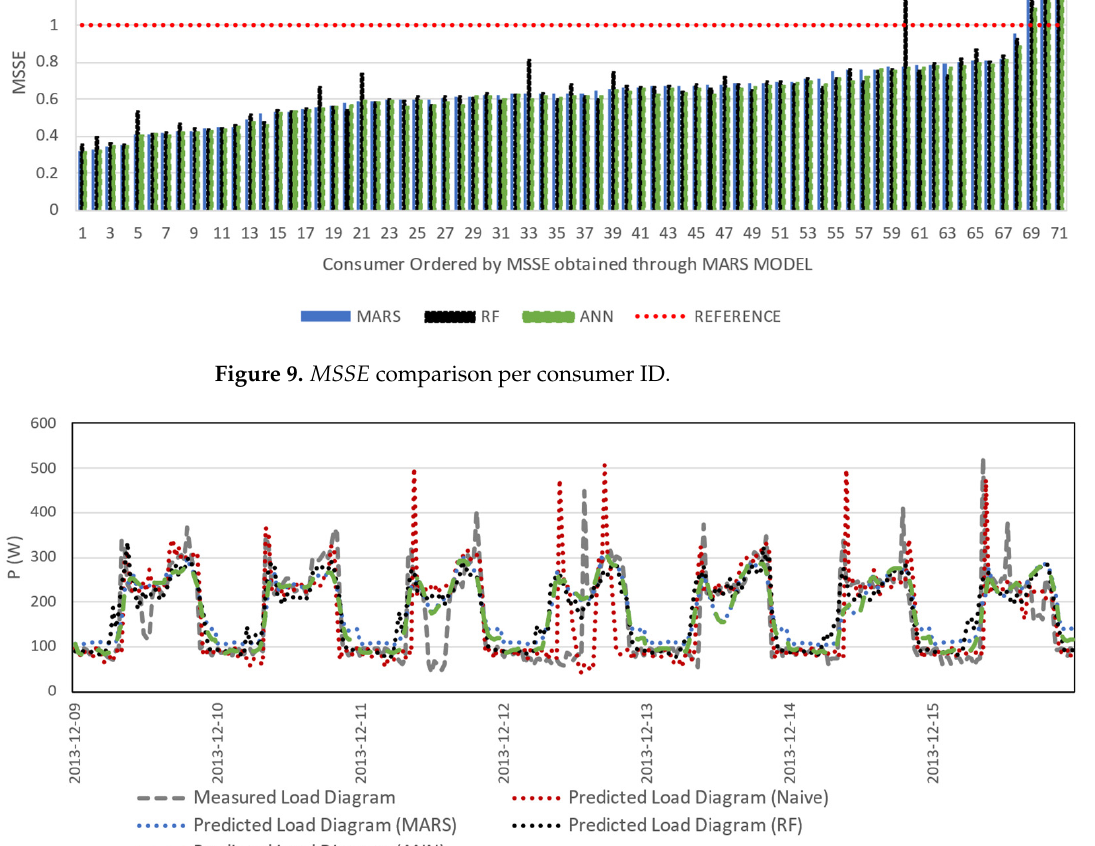
Figure 11. Second comparison of day-ahead predicted and measured load profiles (during a week of the test period)—#Consumer 59. The randomness in resulting active power series is clear and some abrupt changes (sudden peak values or unexpected low values) in active power load are in some cases difficult to predict with the different methodologies. The two presented consumers were chosen due to considerably different consumption volumes as well as load patterns. 3.3. In-Depth Analysis of the Trained Models With the MARS, RF and ANN models already trained and providing the most accu- rate predictions for each consumer, it becomes relevant to proceed to a zoom-in look, with the intention of evaluating features’ relevance, training times and also, for the case of ANNs, the networks’ dimension. To evaluate features’ relevance in MARS models, the dependence of each model on the different features was identified and, for the different hinge functions and eventual linear dependences of single features, an average of absolute coefficient values was com- puted. After aggregating the effect verified for the studied consumers, normalised aver- ages (sum of values equal to 1) are presented in Figure 12. The labels are related with the used features (from x 0 to x 17 ) already presented in Table 2. It can be noted that the features x 0 , x 3 , x 8 , and x 13 tend to be the most influential in MARS models.